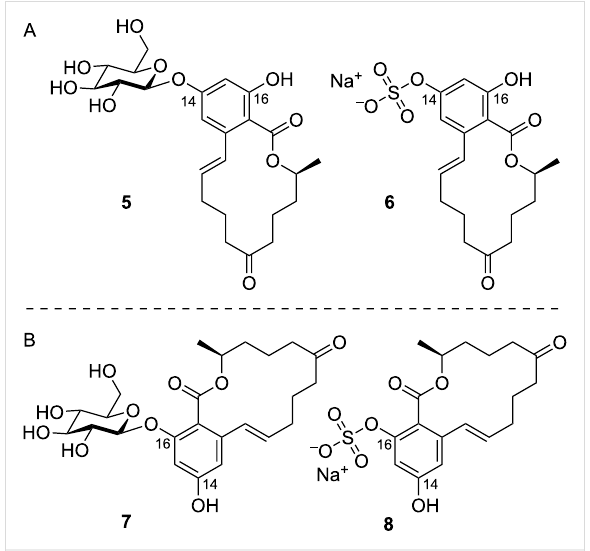
Figure 2: Structures of zearalenone conjugates: (A) ZEN-14- β ,D- glucoside ( 5 ) and ZEN-14-sulfate ( 6 ), (B) ZEN-16- β ,D-glucoside ( 7 ) and ZEN-16-sulfate ( 8 ). Sulfates shown as sodium